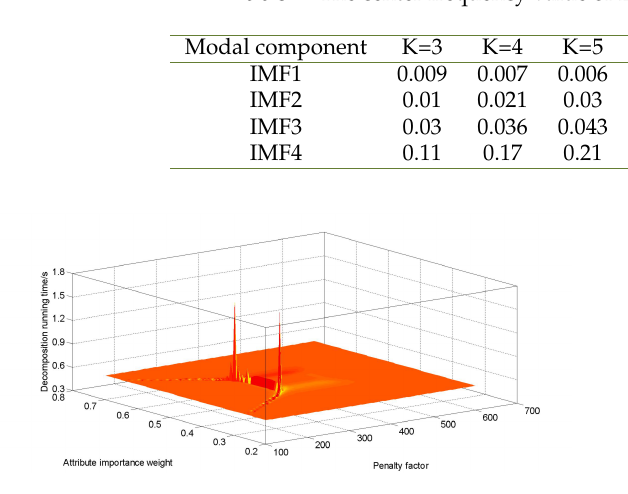
Fig. 5. Running time of recursive decision tree algorithm Fig. 6. Decompose the power load forecasting curve of decomposition of subset entropy attribute under different different algorithms for each component (a) Power load penalty factors forecasting curve of different algorithms for